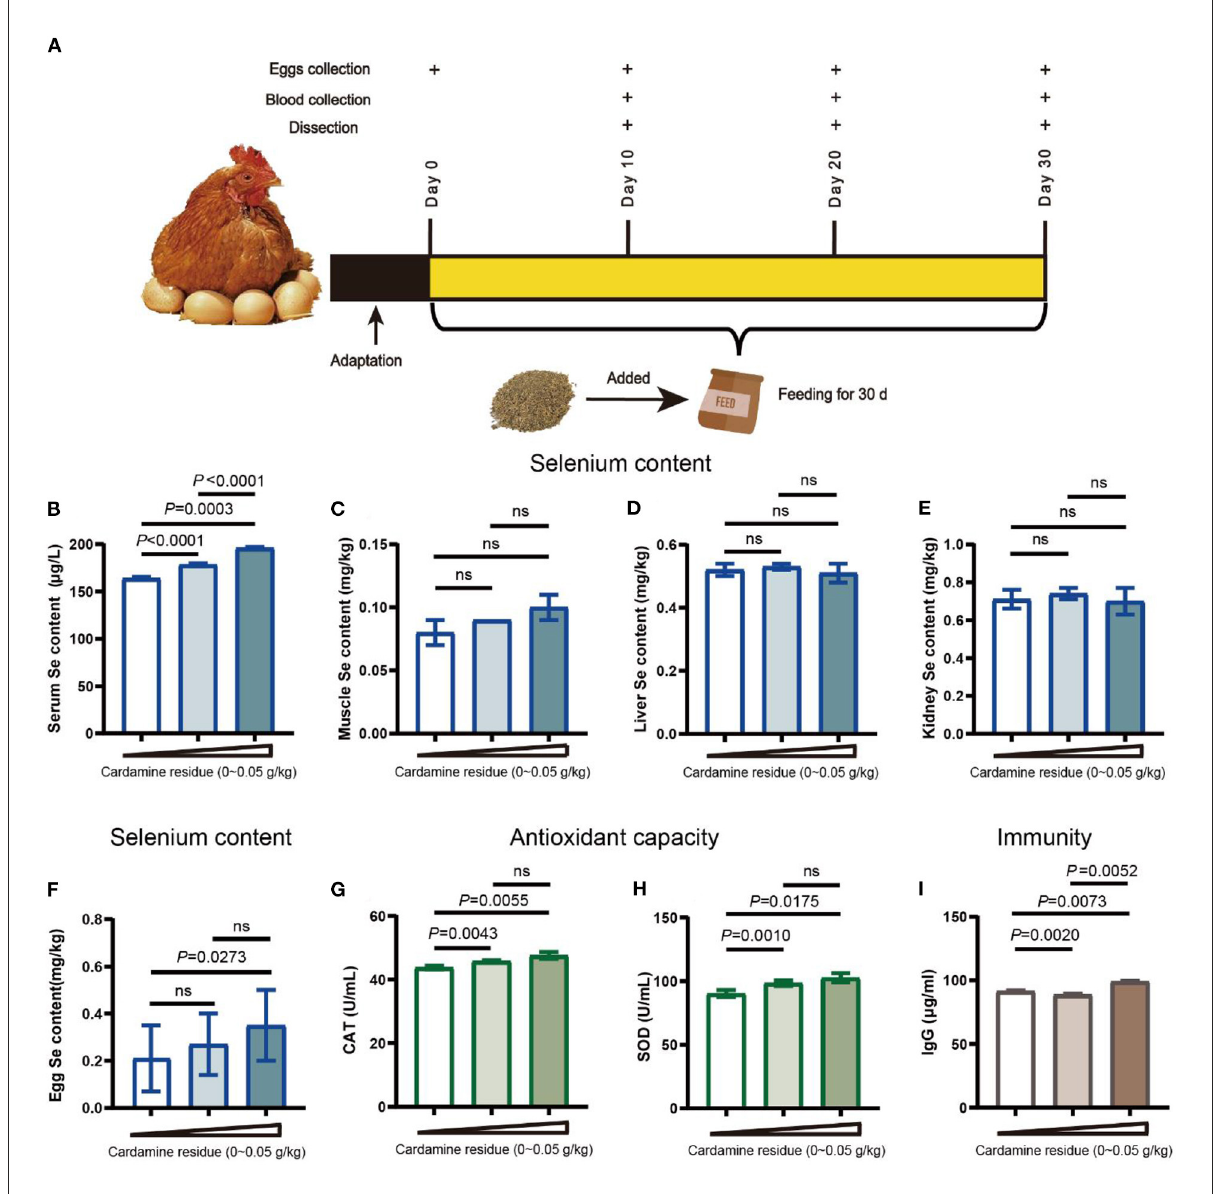
FIGURE1 Effects of DCH on antioxidant capacity and immunity. (A) Workflow of the experiment. The laying hens were fed for 30 days and collected eggs on days 0, 10, 20, and 30 for production performance and eggs quality evaluation. Serum samples and organ samples were collected on the day 30 for growth performance evaluation. (B–I) Effects of DCH on serum selenium, organs selenium, egg selenium, antioxidant enzyme levels, and IgG level. (B) Selenium in serum of each group. (C) Selenium in muscle of each group. (D) Selenium in liver of each group. (E) Selenium in kidney of each group. (F) Selenium in eggs of each group. (G,H) The levels of antioxidative enzymes of SOD and CAT in serum of laying hens in each group. (I) IgG level in serum of laying hens in each